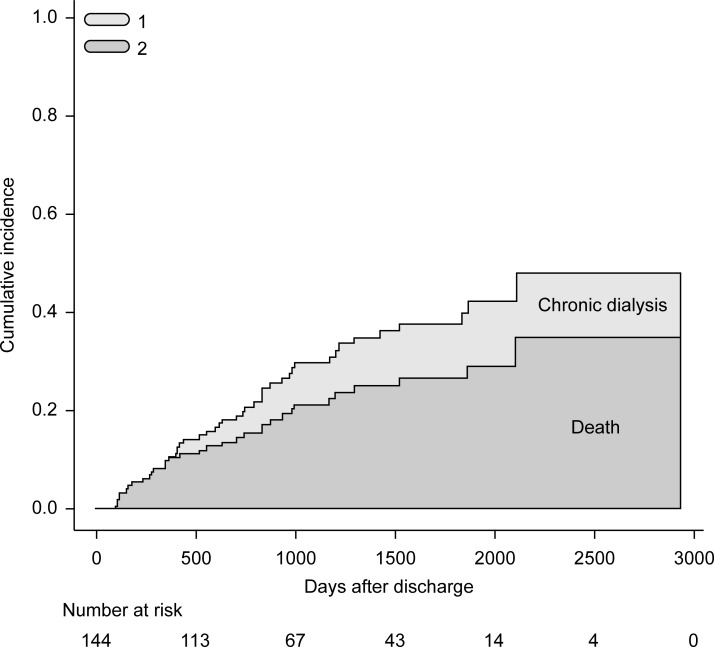
Cumulative incidences of the composite of death and initiation of chronic dialysis.(1) Indicates the cumulative incidence of initiation of chronic dialysis (13.3%) and (2) indicates the cumulative incidence of death (34.9%) during the observation period. The cumulative incidence of the composite endpoint of death and initiation of chronic dialysis was 48.2%.